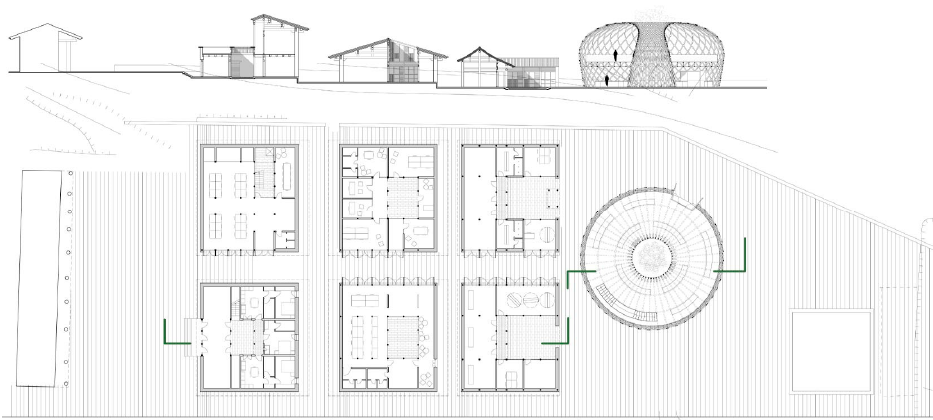
Figure 3. Master plan of the village. Notably, the new functions create a landscape visual interaction between nature and artifacts.